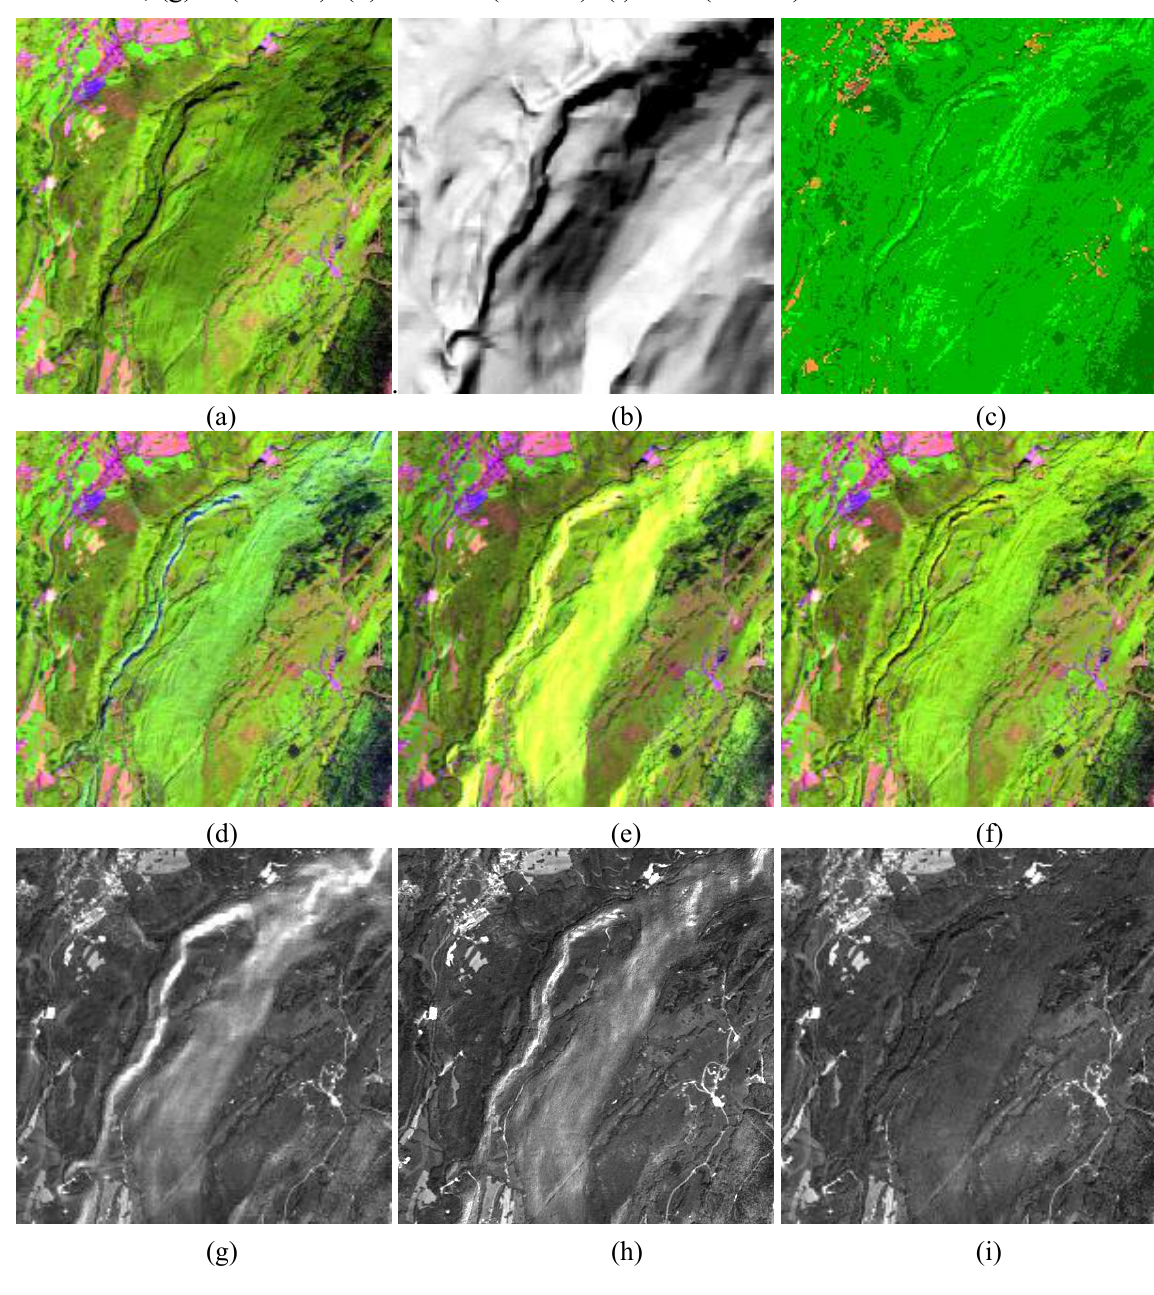
Figure 1. Sub-scene of (a), RGB = bands 4, 3, 2 (1650, 840, 660 nm). (a) Original. (b) Illumination. (c) Classification map. (d) C correction. (e) Gamma correction. (f) MM correction, (g) C (band 1). (h) Gamma (band 1). (i) MM (band